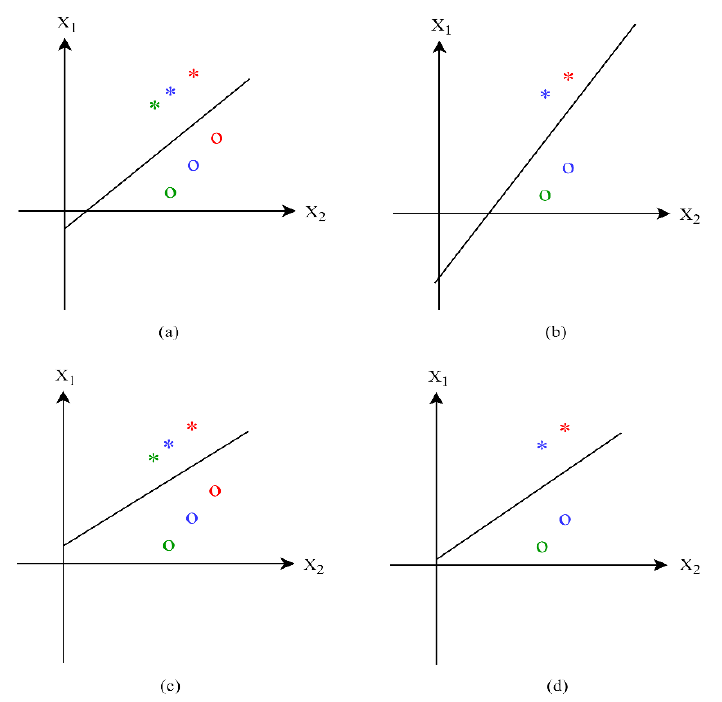
Figure 5. The overall structure of parameter confidence analysis.